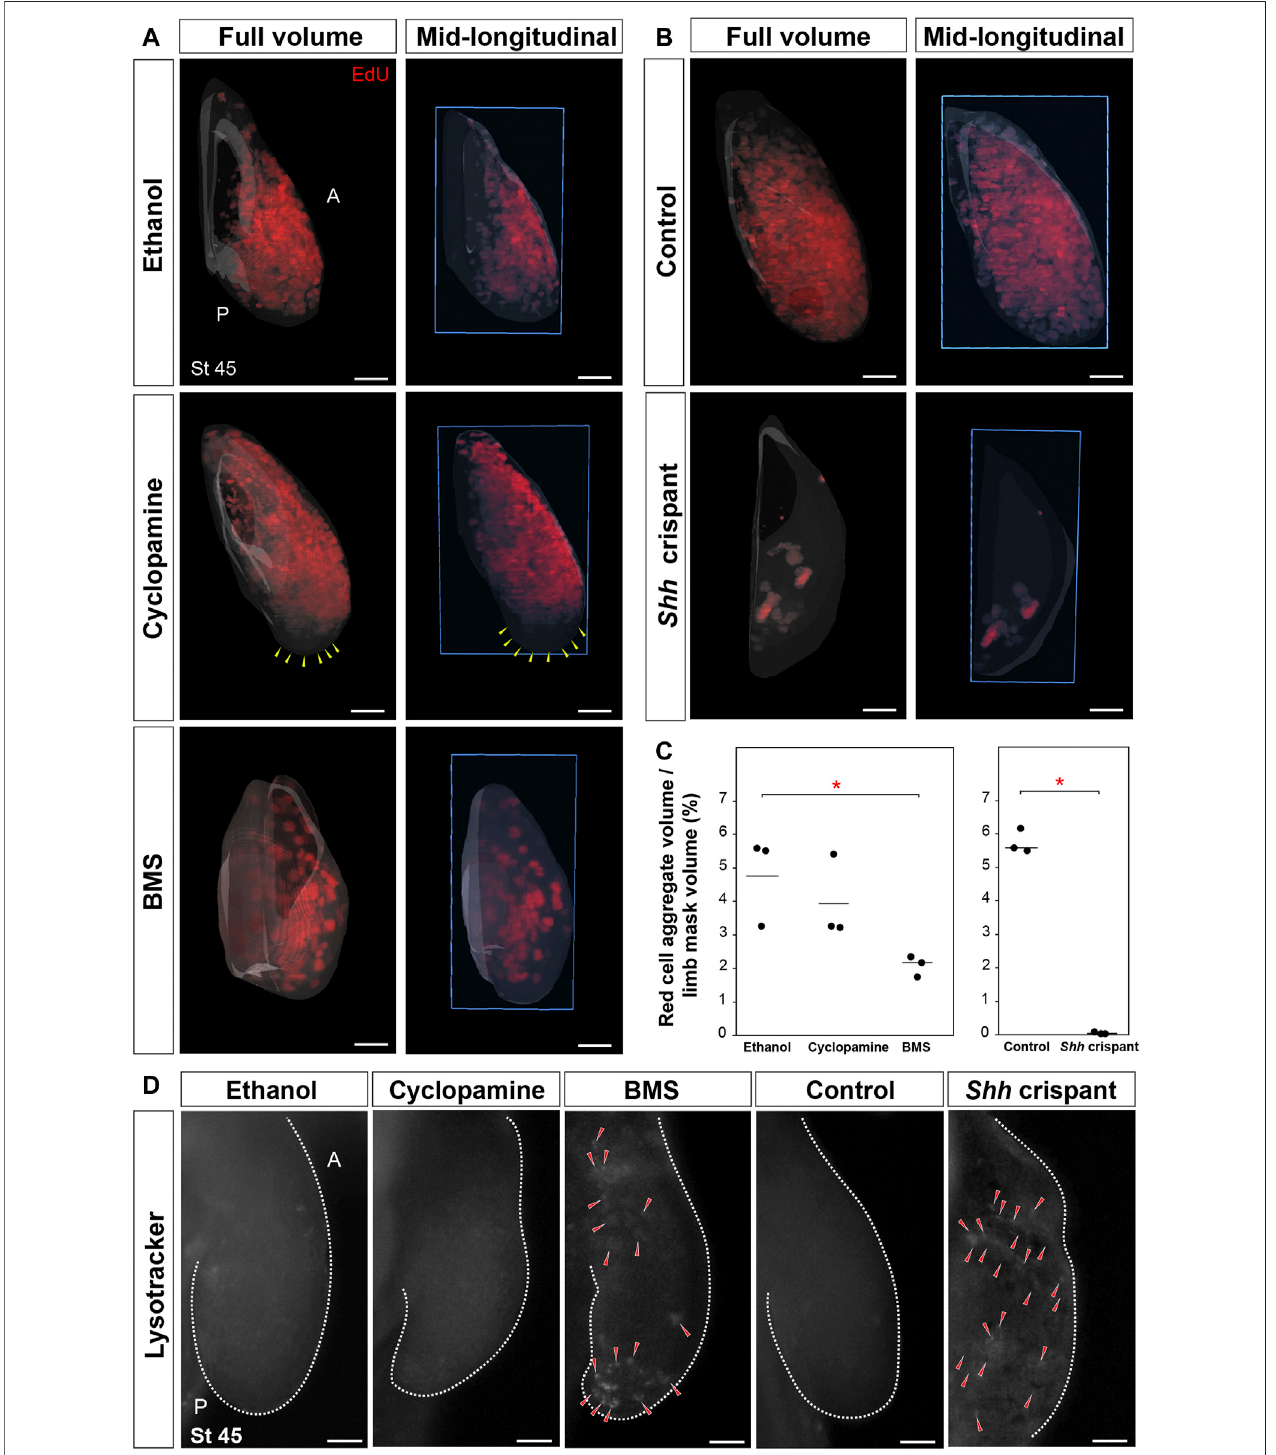
FIGURE 5 | Sonic hedgehog controls cell proliferation and cell survival during axolotl limb development. (A,B) Light-sheet images depicting EdU-positive proliferatingcellsinstage45limbsfromethanol,cyclopamine,orBMStreatmentsandCRISPRcontroland Shh crispantlarvae( n =3pertreatment).Yellowarrows,zone lackingproliferatingcells.Bluebox,planeofmid-longitudinalsection. (C) Stage45limbsfromBMS-treatedlarvaeand Shh crispantlarvaeshowedasigni fi cantdecrease inEdU-positiveproliferatingcells.Horizontalbars,meanvalues;asterisk,signi fi cant p -value[one-wayANOVA,Tukey – KramerHSDposthoctest, F =5.8, p =0.038 (ethanol vs. BMS), p = 0.64 (ethanol vs. cyclopamine), and p = 0.12 (cyclopamine vs. BMS); F = 614, p < 0.0001 (control vs. Shh crispant); n = 3 per treatment]. (D) Cell deathassayusingLysoTrackerinstage45limbinethanol-,cyclopamine-,orBMS-treatedlarvaeandCRISPRcontroland Shh crispantlarvae( n =3per treatment). Red arrows, LysoTracker-positive cells. All limbs are projected in dorsal view with anterior “ A ” on top and posterior “ P ” on the bottom. Scale bar = 100 µm.